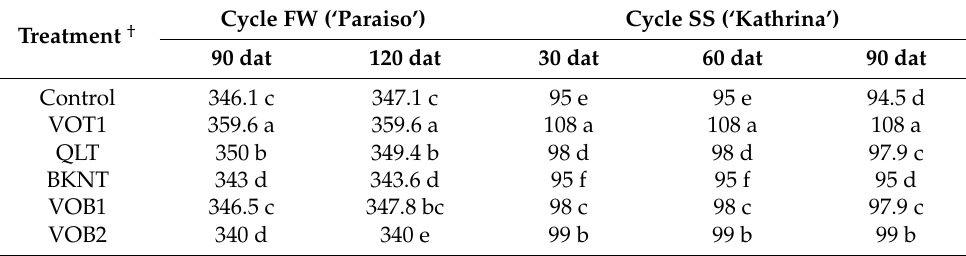
Table 8. Effect of treatments on weight (g) of individual cucumber fruits during the FW and SS cycles.